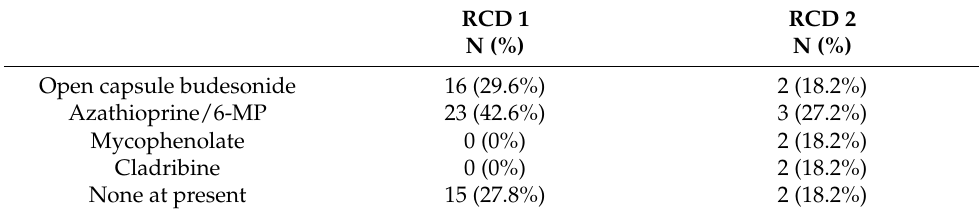
Figure 2. Comparison of patient demographics in RCD. ( A ) Box and whisker plot of age distribution of patients with RCD1 and RCD2; error bars indicate 10th–90th percentile; outliers are plotted as individual data points; comparisons between groups were conducted using two-way ANOVA with post hoc Tukey test. ( B ) Box and whisker plot of time to RCD diagnosis from index CD diagnosis; error bars indicate 10th–90th percentile; outliers are plotted as individual data points; comparison between groups was conducted using the Mann–Whitney test. * = p < 0.05; ** = p < 0.01; **** = p < 0.0001. Dx = diagnosis. Table 2. Current treatment in patients with RCD1 and